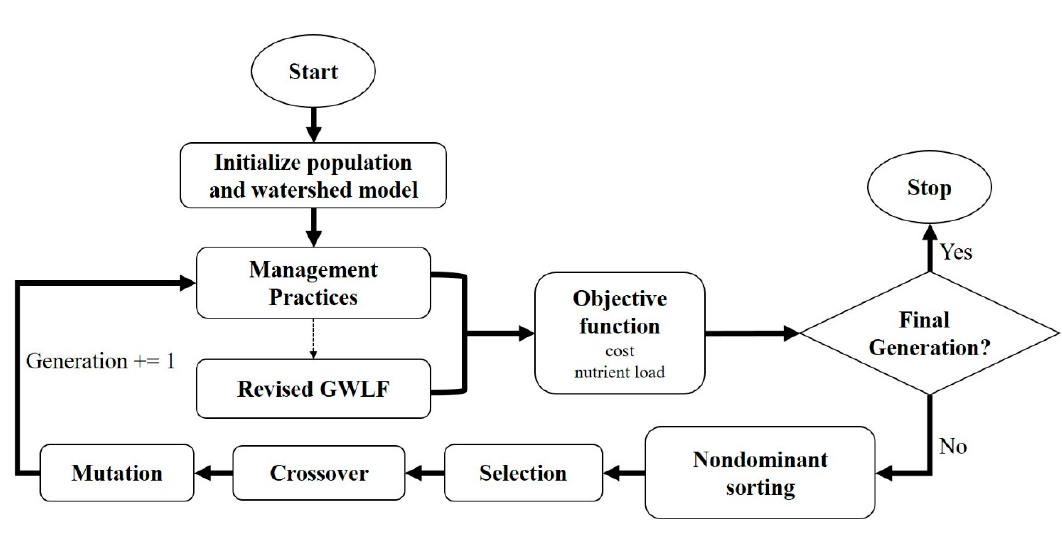
Figure 3. The optimization process for BMP selection and placement.